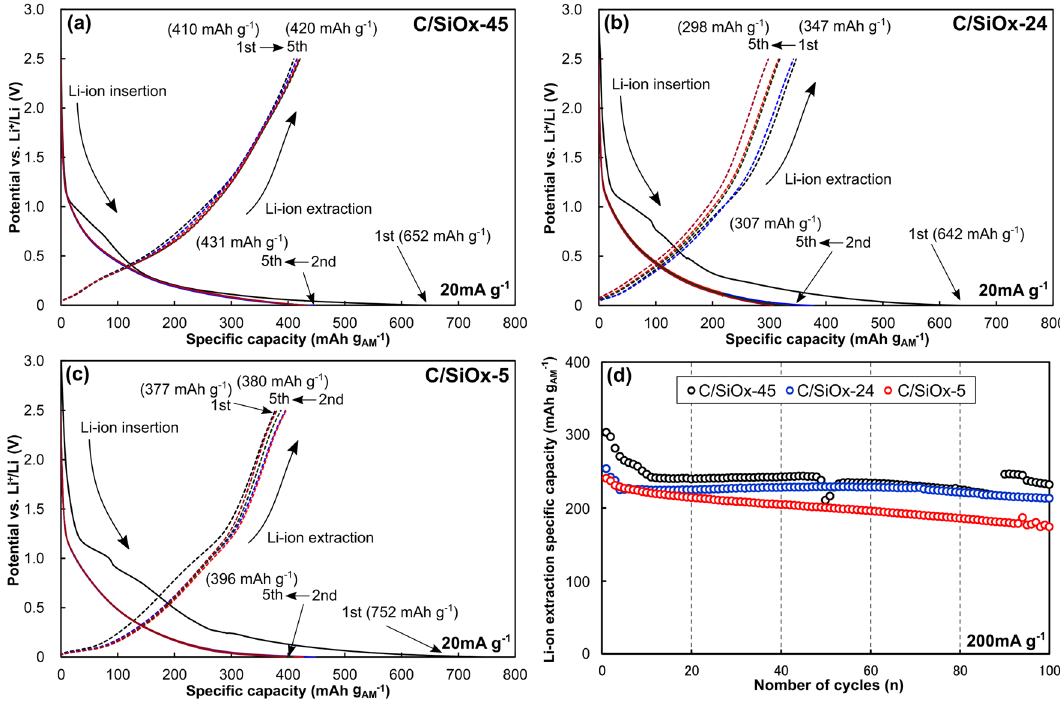
Figure 2. Initial Li-ion insertion and extraction properties of ( a ) C/SiO x -45, ( b ) C/SiO x -24, and ( c ) C/SiO x -5 in a coin-type half-cell configuration at 20 mA g AM −1 , and ( d ) their cycling stabilities at 200 mA g AM −1 in the half- cell configuration in the 0–2.5 V (vs. Li + /Li) electrode potential